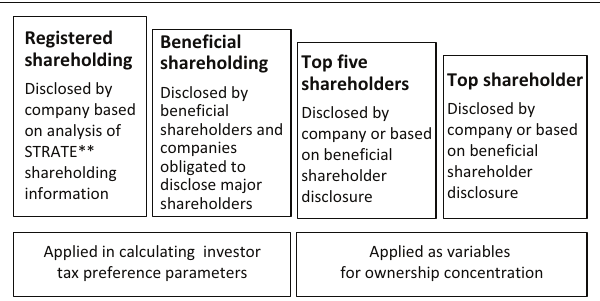
FIGURE 1: Levels of shareholding data representing data sources used in the